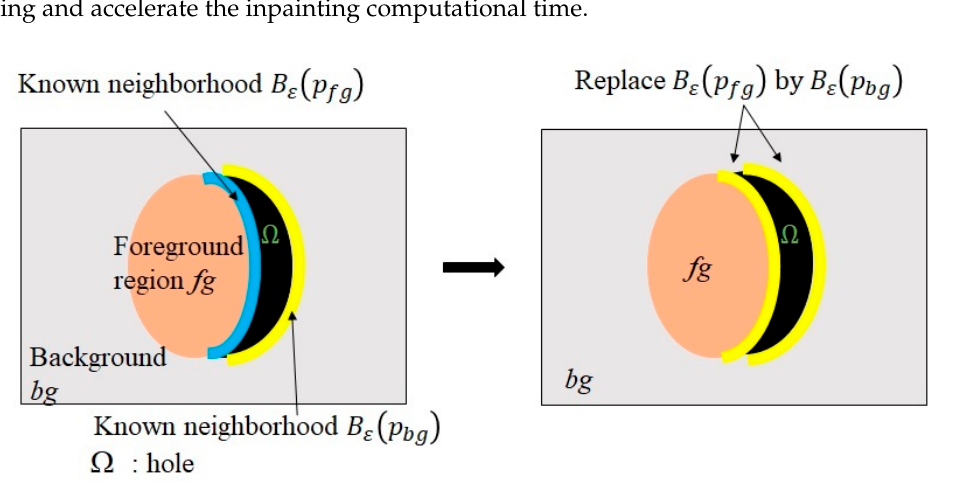
Figure 13. Example of boundary region replacement for hole.